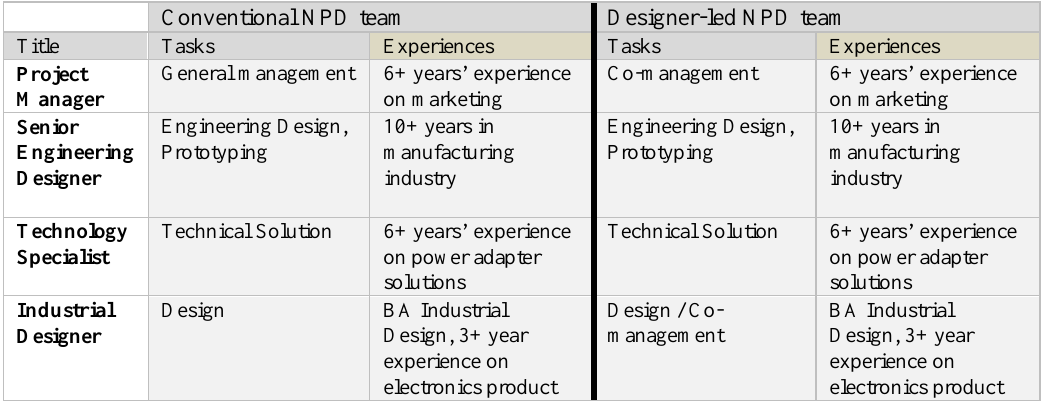
Table 4: Members’ Expertise and Backgrounds